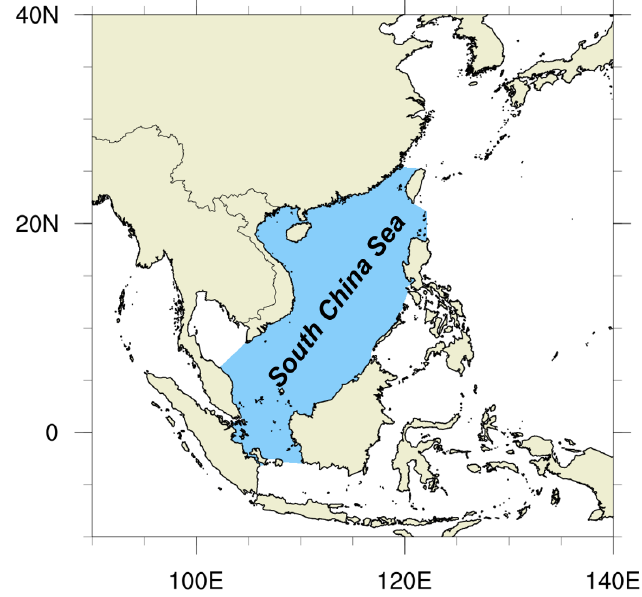
Figure 1. Location of the study area: South China Sea (shaded in